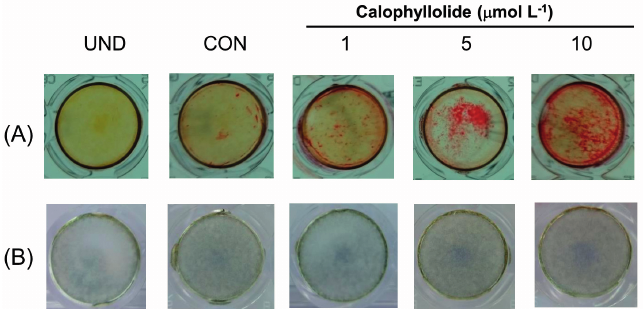
Figure 6. Effects of calophyllolide on mineralization and ALP stain of MC3T3-E1 cells. After treated MC3T3-E1 cells with calophyllolide (1, 5, and 10 μ mol·L − 1 ), Alazarin red-S staining procedure ( A ) and ALP staining procedure ( B ) were used to investigate the effects of calophyllolide on MC3T3-E1